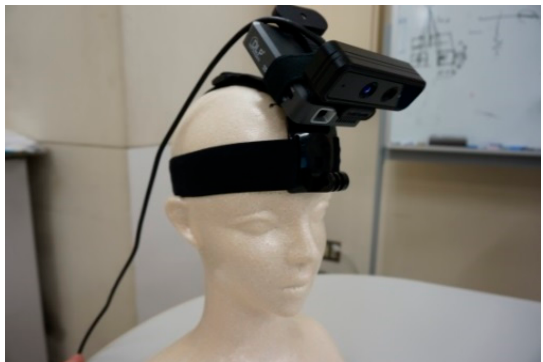
Figure 2. Experimental system. A mobile projector that a depth camera is attached to is worn on the user’s head.